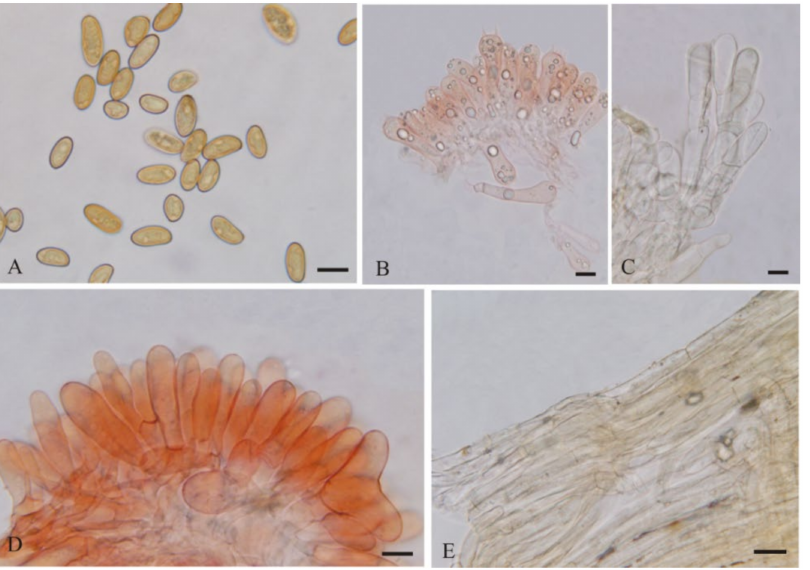
Figure 7. Pseudosperma laricis (BJTC FM887) ( A ) Basidiospores, ( B ) Basidia, ( C ) Caulocystidia, ( D ) Cheilocystidia, ( E ) Pileipellis. Scale bars: ( A – E ) = 10 µ m. MycoBank: